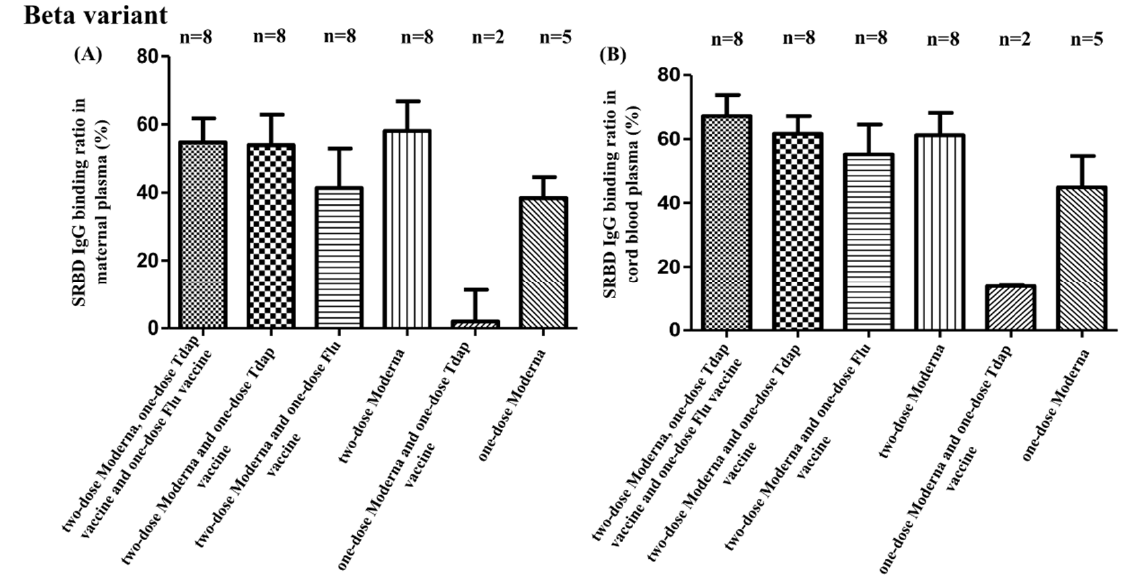
Figure 2. ( A ) SRBD IgG binding ratio against Beta variants from maternal plasma in different vaccine combinations. ( B ) SRBD IgG binding ratio against Beta variants from neonatal cord blood for different vaccine combinations. Tdap vaccine, tetanus toxoid, reduced diphtheria toxoid, and acellular pertussis vaccine; flu vaccine, influenza vaccine.